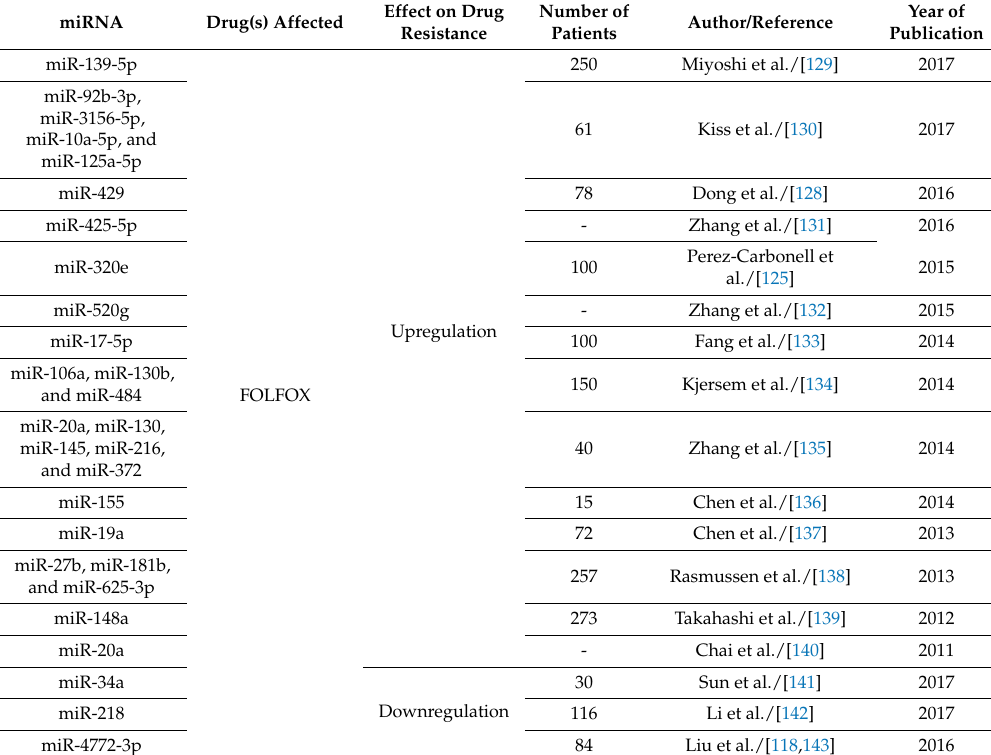
Table 2. miRNAs functions in therapeutic resistance in